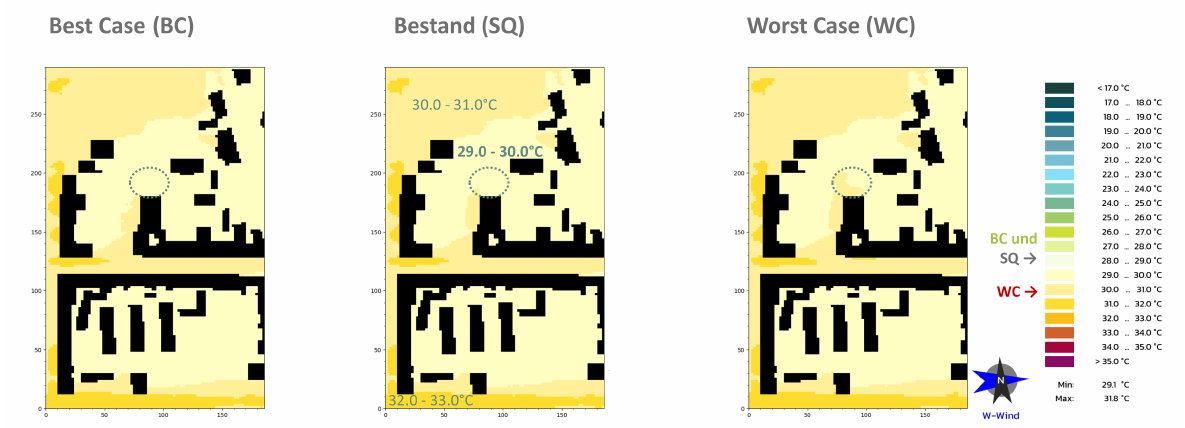
Figure 2. Air temperature 3 pm – Comparison between best case (BC), the state of the art (SQ) and the worst case (WC) scenarios. Simulation processing by grünplan.